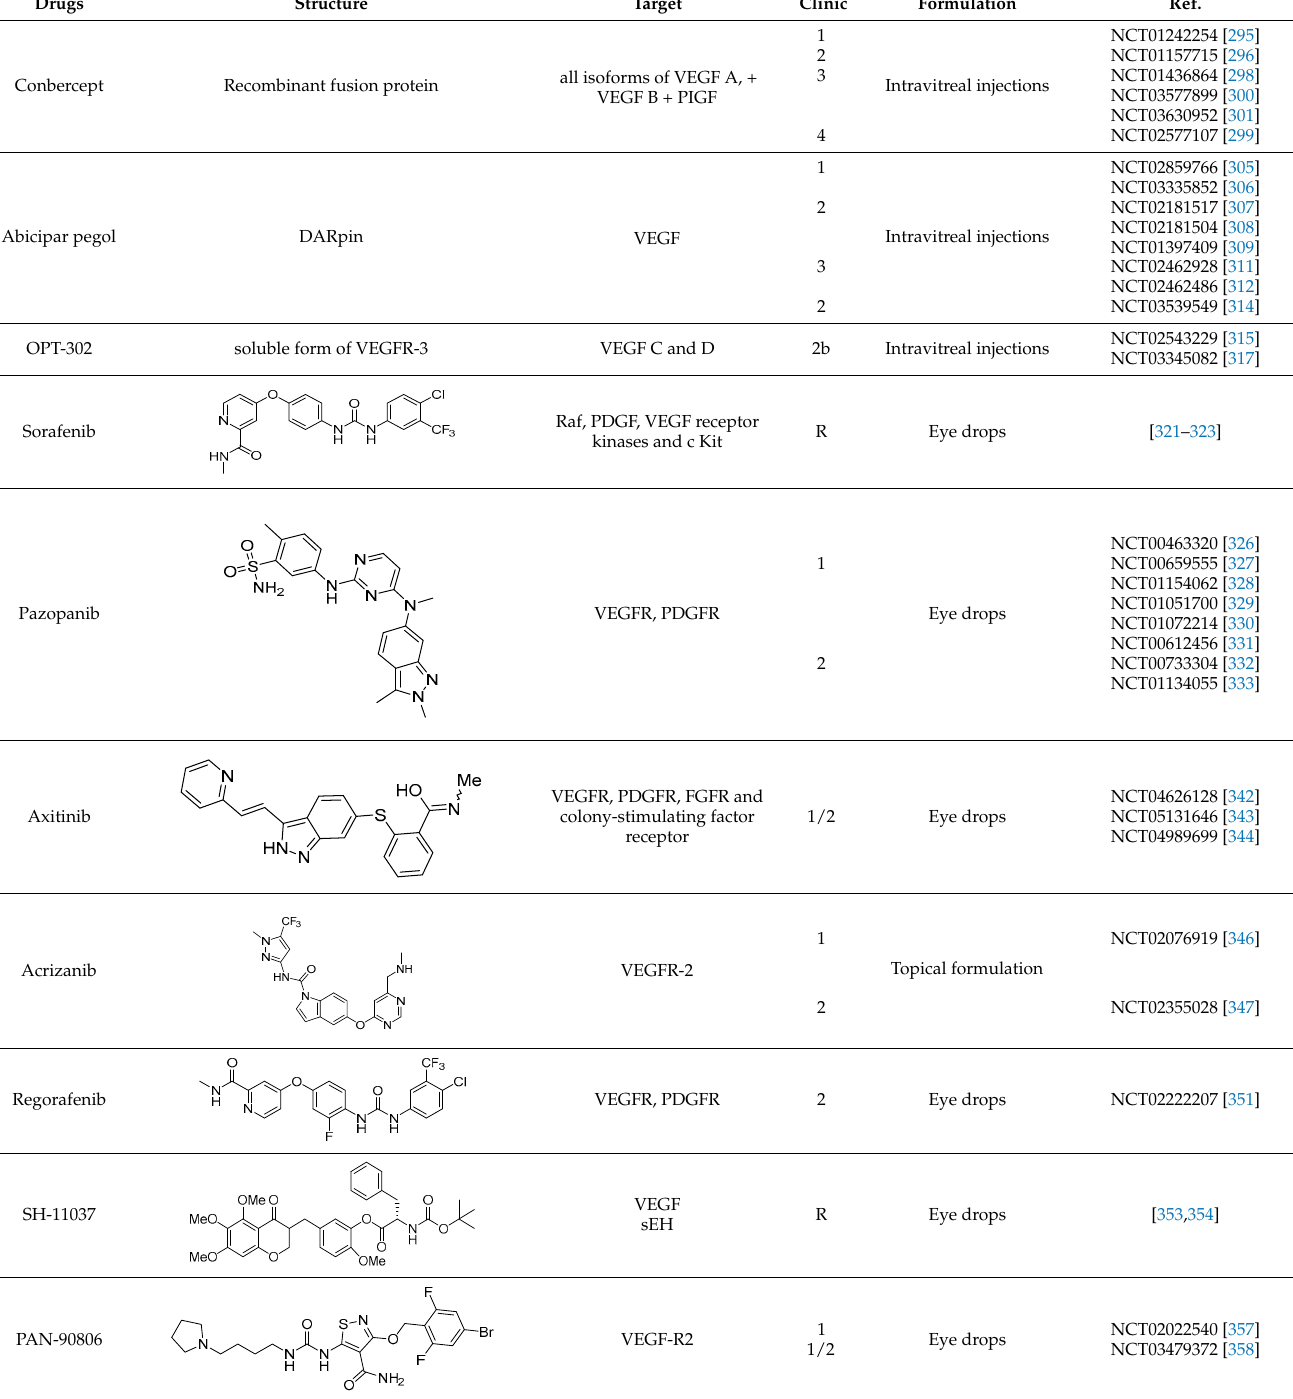
Table 11. Summary of drugs developed against exudative AMD.